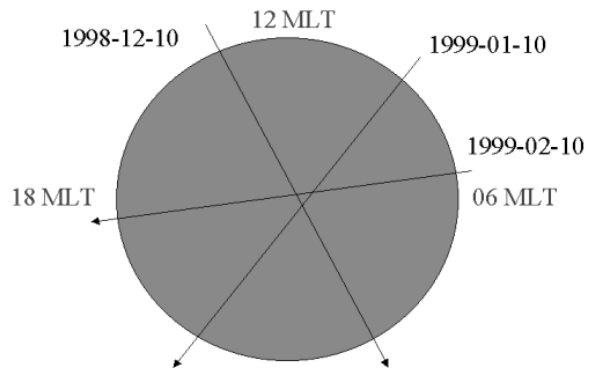
Fig. 1. Variations of the orbital plane during the mission lifetime.